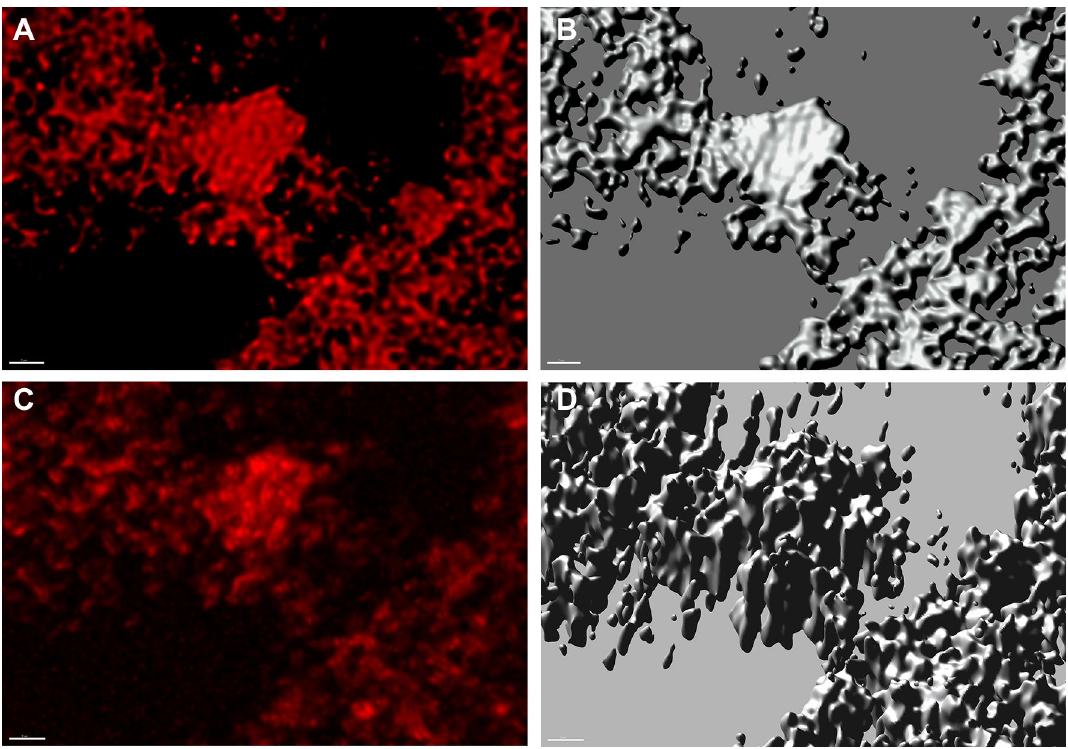
Figure 6. Confocal laser scanning microscopy (CLSM) imaging of Chl fluorescence of LHCII 3 from the same area of GE-LHCII 3 -PPBQ before ( A , B ) and after 20 min of OCP treatment ( C , D ). The images were registered with the use of a special holder (Schematic diagram S2) for CLSM. For better visualization of the 3D distribution of LHCII 3 inside GE the area incompletely covered by complexes was selected. The left panel ( A , C )—top view of the 3D distribution of red Chl fluorescence, the right panel ( B , D )—the computer-generated 3D reconstruction of the fluorescence surface presented at a 10°